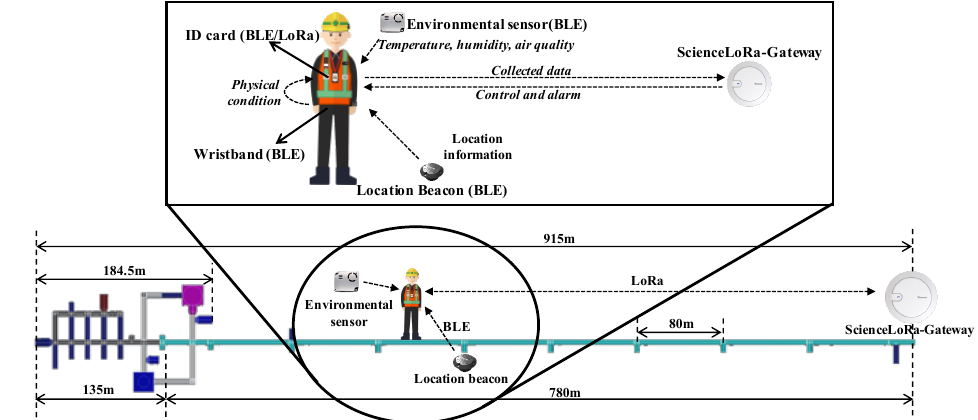
Figure 14. Schematic diagram of the safety service in underground research